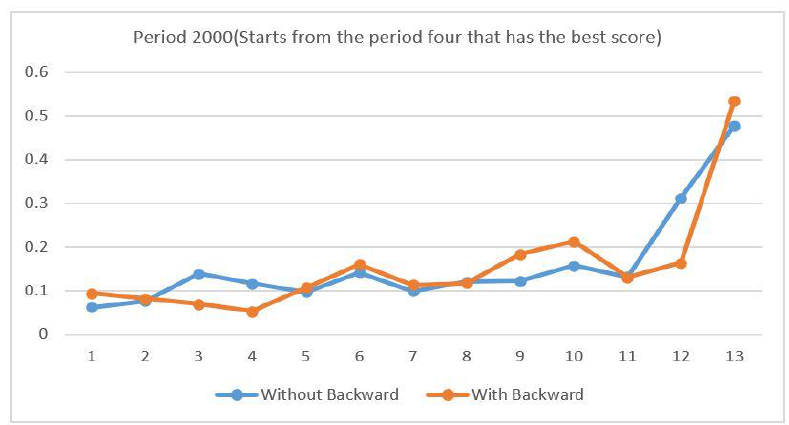
Figure 13. The scores with and without backward to find the best period to start with.